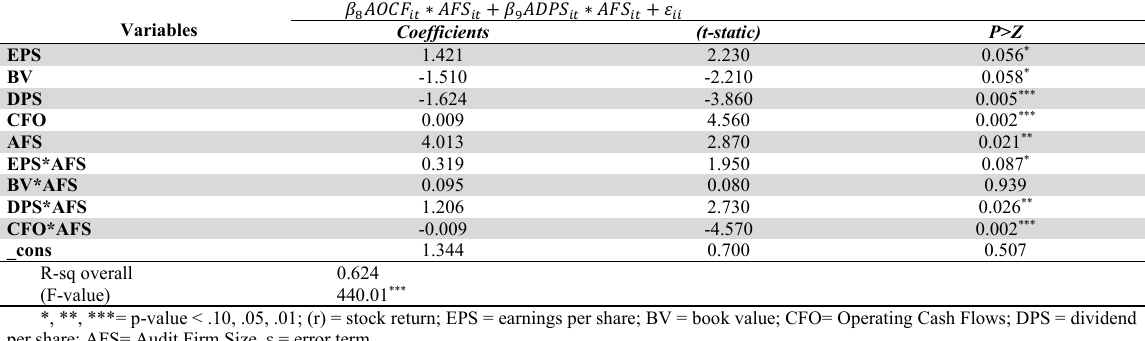
Results of Regression Analysis Related to Model (2)